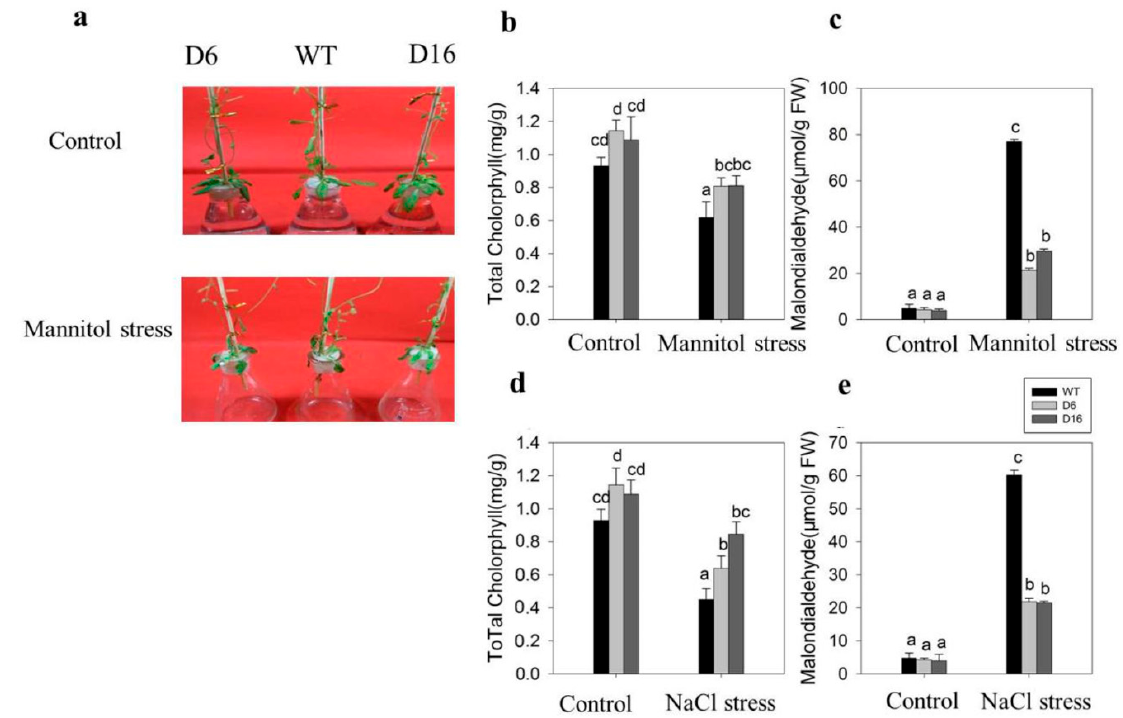
Figure 7. Related-physiological indices of Arabidopsis thaliana under salt and osmotic stress treatments. ( a ) The phenotypes of wild type (WT) and CaDHN5 -overexpressing transgenic plants (D6 and D16) under mannitol treatment; ( b ) effects of mannitol treatment on total chlorophyll in transgenic Arabidopsis plants; ( c ) effects of mannitol treatment chlorophyll content in transgenic Arabidopsis plants; ( d ) effects of NaCl treatment on MDA content in transgenic Arabidopsis plants; ( e ) effects of NaCl treatment on total chlorophyll content in transgenic Arabidopsis plants. Data that are significantly different are indicated with letters above the error bars (±S.D.). The different letters with the bars indicate significant differences as determined using Tukey HSD’s multiple range tests ( p < 0.05).